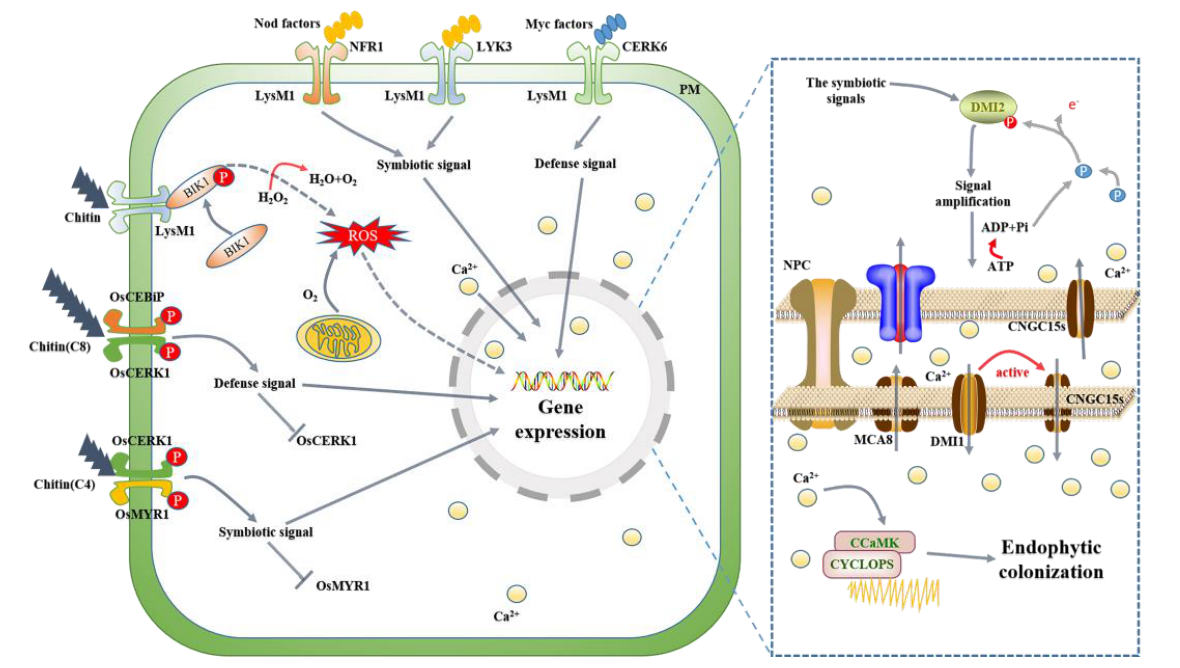
Figure 2. Patterns of molecular mechanisms underlying the initiation of symbiotic or immune responses of plants to signaling molecules during mycorrhizal interactions. LysM1 receptor modules interact with different proteins to form unique-acting receptors on plant cell membrane surfaces (NFR1, LYK3, CERK6, OsMYR1-OsCERK1, OsMYR1-OsCEBIP et al.), and some receptors antagonize each other, such as the OsMYR1-OsCERK1 receptor and the OsMYR1-OsCEBIP receptor. When mycorrhizal interactions occur, extracellular signal molecules (Nod factor, Myc factor, chitin et al.) with these particular receptor combinations form defense or symbiotic signals in the cytoplasm, which initiate the plant cell ’ s internal defense or the expression of related genes. In addition, symbiosis and defense reactions in the process of symbiosis are accompanied by strong calcium oscillation in the nuclei. In calcium excitation, the symbiotic signal activates DMI2 protein under the action of related receptors, and the related channel proteins DMI1 and CNGC15s on the nuclear membrane are activated through the signal cascade reaction. The electrochemical signal in the nucleus changes dramatically, resulting in the movement of Ca 2+ between the inner and outer membrane of the nucleus and the perinuclear lumen.